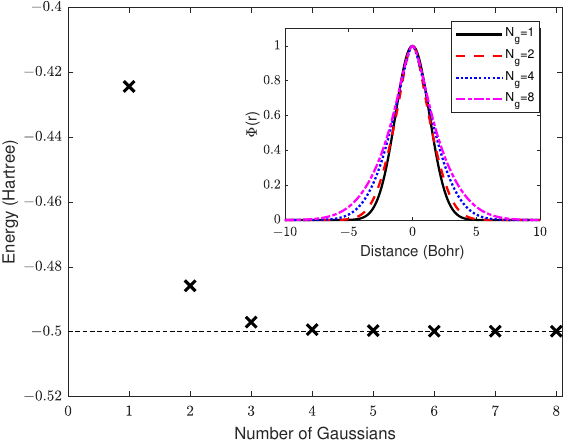
Figure 1. The ground state energy of the hydrogen atom. The crosses were the calculated from minimization of the energy equations as the number of Gaussian basis functions were increased. The dotted line shows the exact ground state energy of hydrogen [44]. The insert shows the changes to the shape of the wave functions with an increasing number of basis functions. Beyond four Gaussians, improvements in the ground state energy and shape of the wave function are